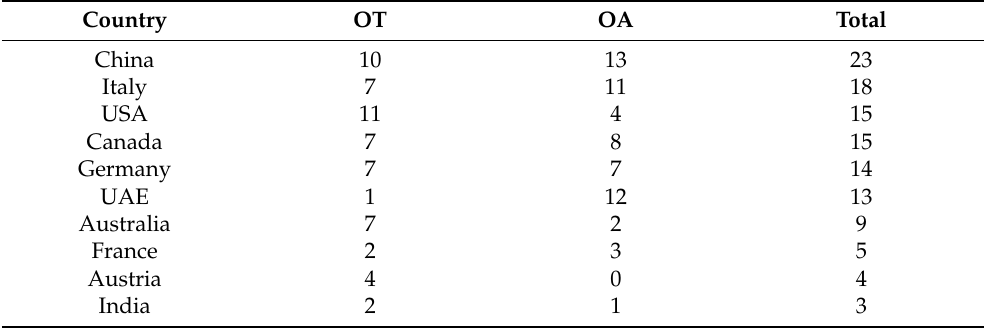
Table 4. Distribution among the ten most productive countries.